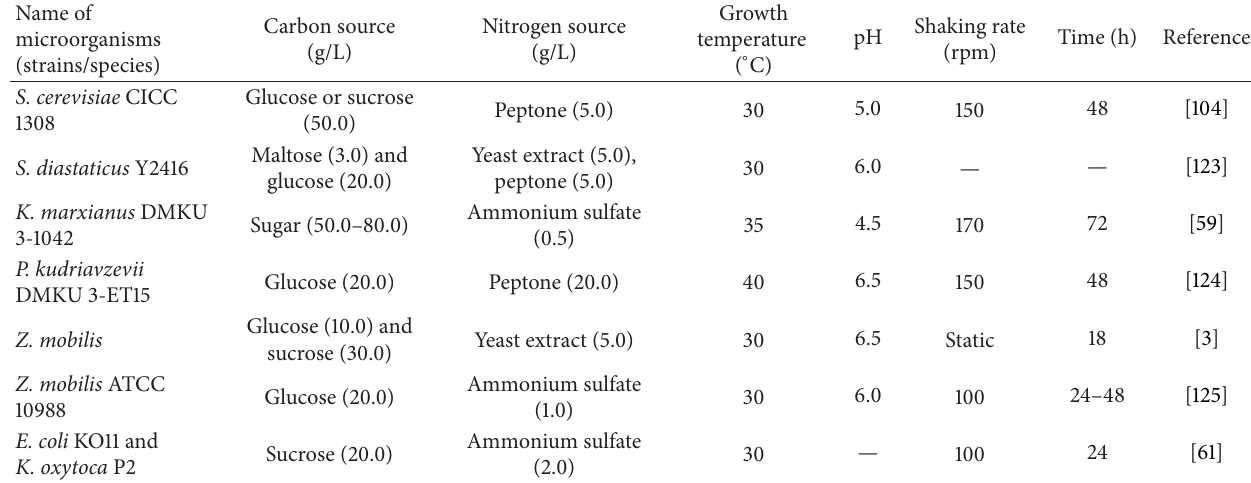
Table 3: Growth condition of microorganisms involved in ethanol